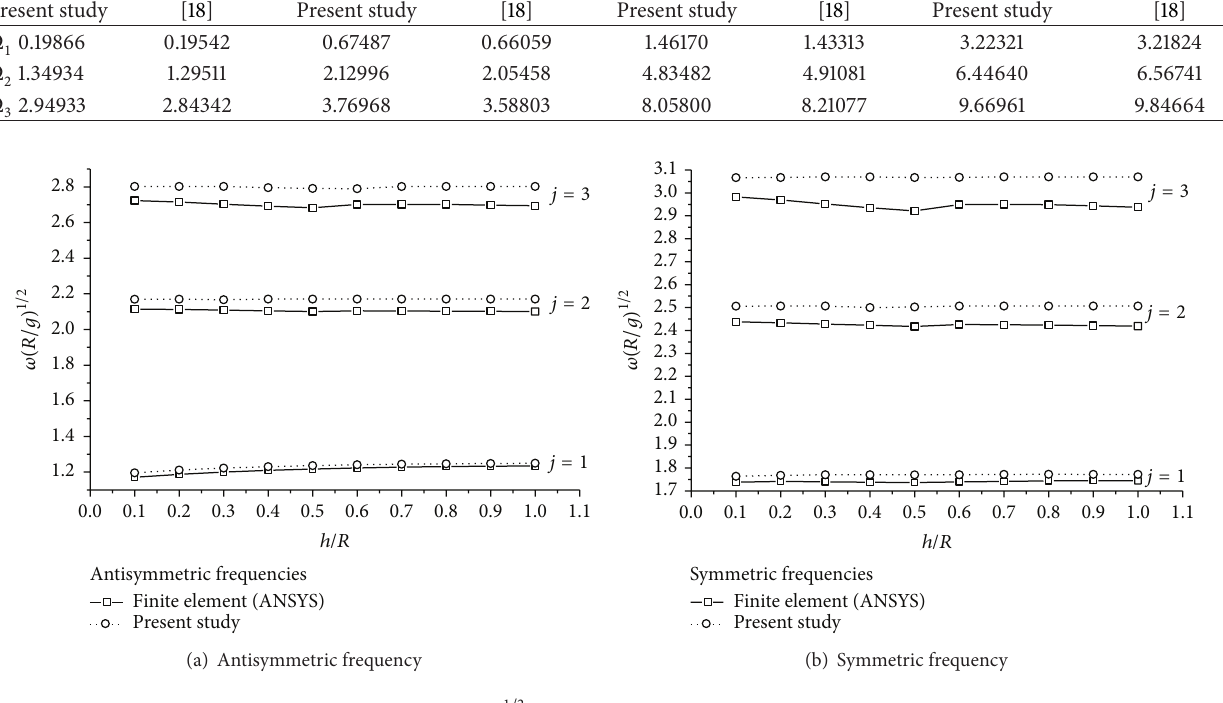
Figure 9: Variation of 𝜔(𝑅/𝑔) 1/2 with liquid-depth ratio ℎ/𝑅 (U-shaped aqueduct).